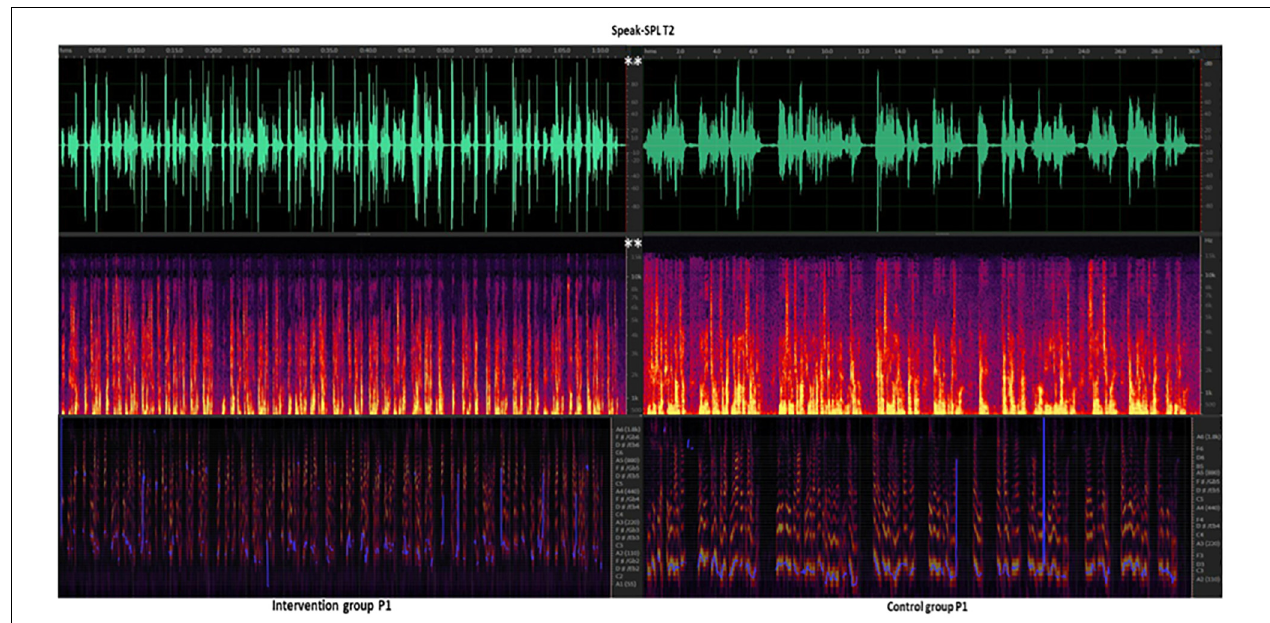
FIGURE 10 | Intervention group vs. Control group at T2 time point Speech-SPL (dBA) after the 12-week intervention. P, patient. Speech-SPL T2, intervention group patients vs. control group of Speak -SPL at T2 time point of spectral analysis. Line 1, green, the waveform spectrum represents the sound decibel (dBA) value; Line 2, purple, red, and yellow, fundamental frequency (F0, Hz) values; Line 3, purple, blue, indicates pitch (reference value). White ∗∗ indicates the p < 0.01, and the difference between groups is very